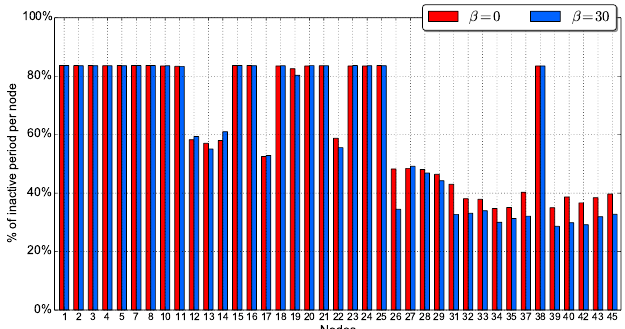
Figure 17. Average duty cycle per node as a function of β